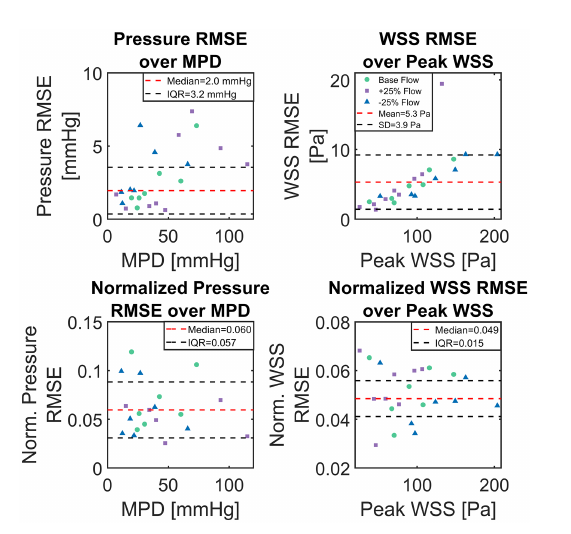
FIGURE 7 Scatter plots of absolute and normalized root-mean-square-errors (RMSE), calculated between computational fluid dynamics (CFD) simulations and artificial neural network (ANN)-based results for the set of 23 test cases. Top shows absolute pressure and wall-shear- stress (WSS) RMSE over CFD computed maximum pressure drop and maximum WSS, respectively. Bottom shows pressure and WSS RMSE normalized with TPG and maximum WSS,